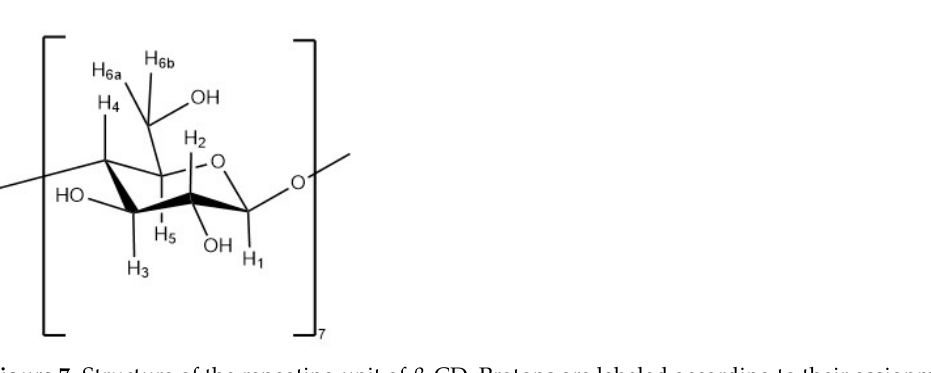
Figure 6. FT-IR spectra of geranium Egyptian (GE) essential oil, β -cyclodextrin, and inclusion com- plexes GE-1 and GE-2. Spectra were obtained from 400–4000 cm − 1 with a resolution of 3.857 cm − 1 as an average of 32 scans on an FT-IR spectrophotometer.